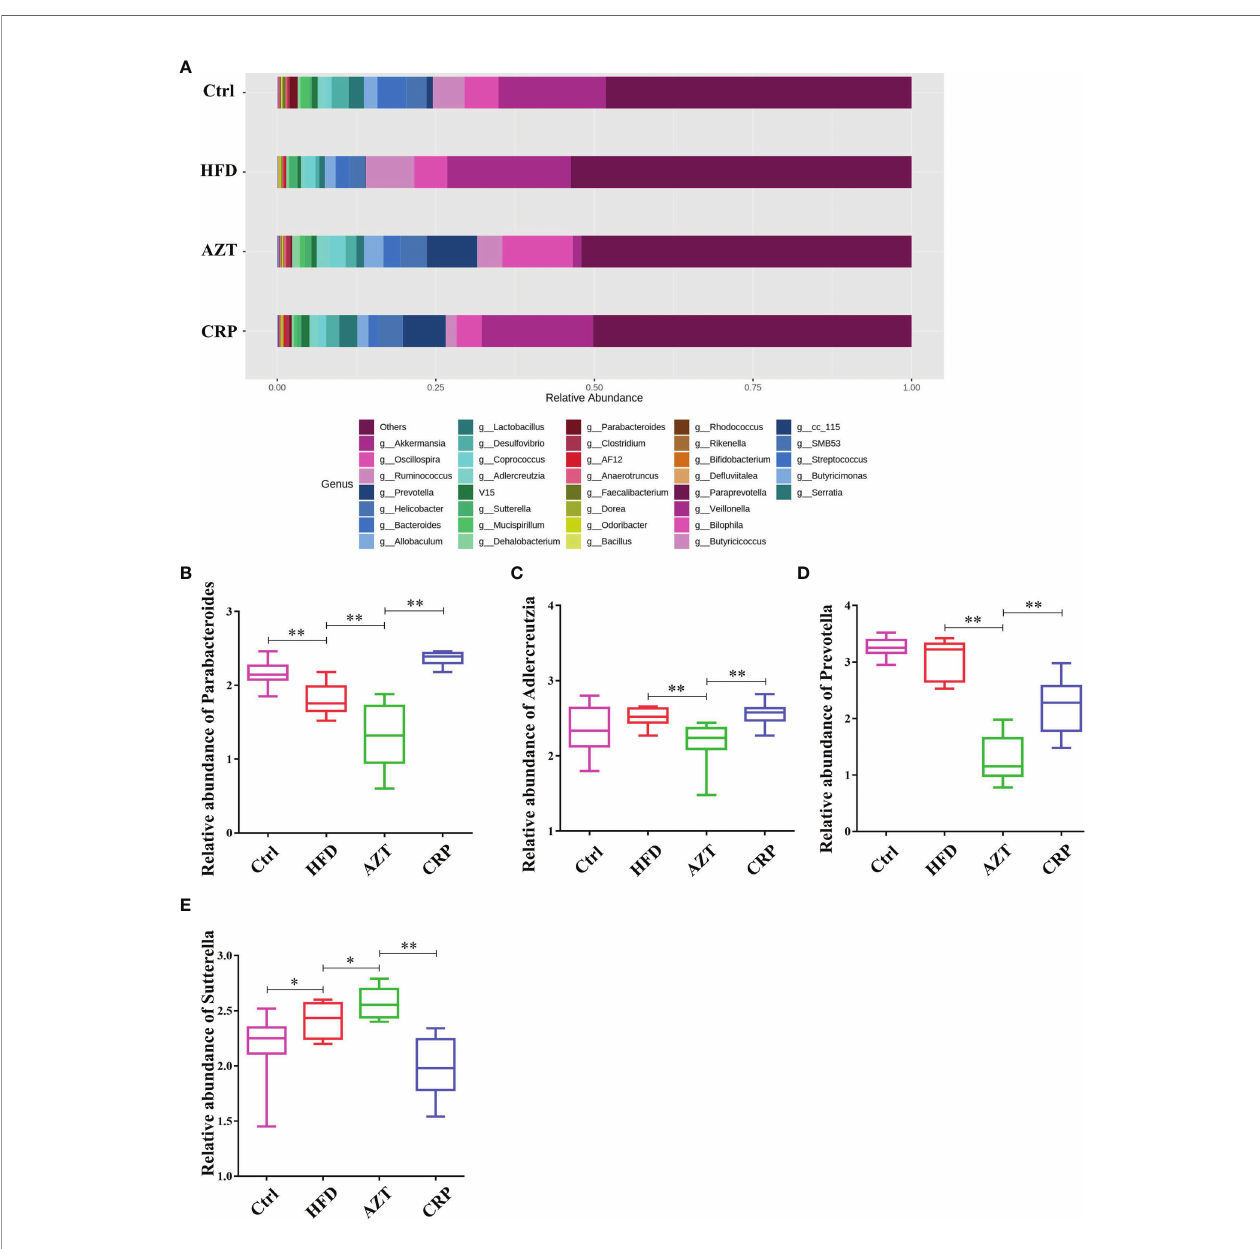
FIGURE 9 | Changes in microbes at the genus level in faeces between the groups. (A) Changes in the relative abundance of microbes at the genus level. (B) Relative abundance of Parabacteroides. (C) Relative abundance of Adlercreutzia. (D) Relative abundance of Prevotella. (E) Relative abundance of Sutterella. Data are expressed as the mean ± SEM, n = 9 for the CRP group and n = 10 for the other groups. *P < 0.05, **P <